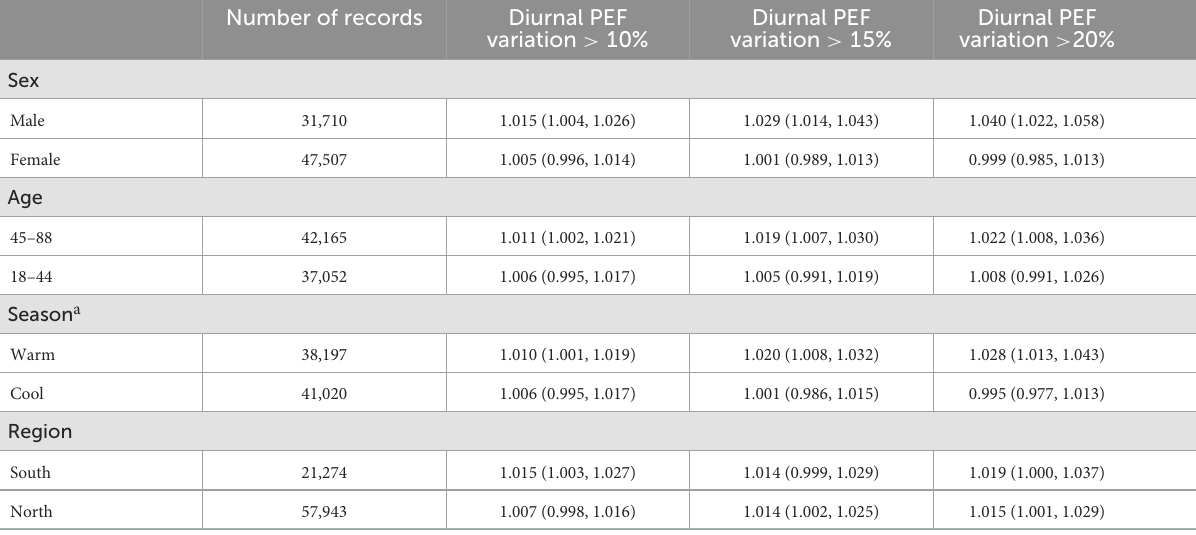
TABLE 4 Odds ratios of asthma exacerbations associated with a 10 µ g/m 3 increase in ozone concentrations, classified by sex, age, season of lung function tests, and